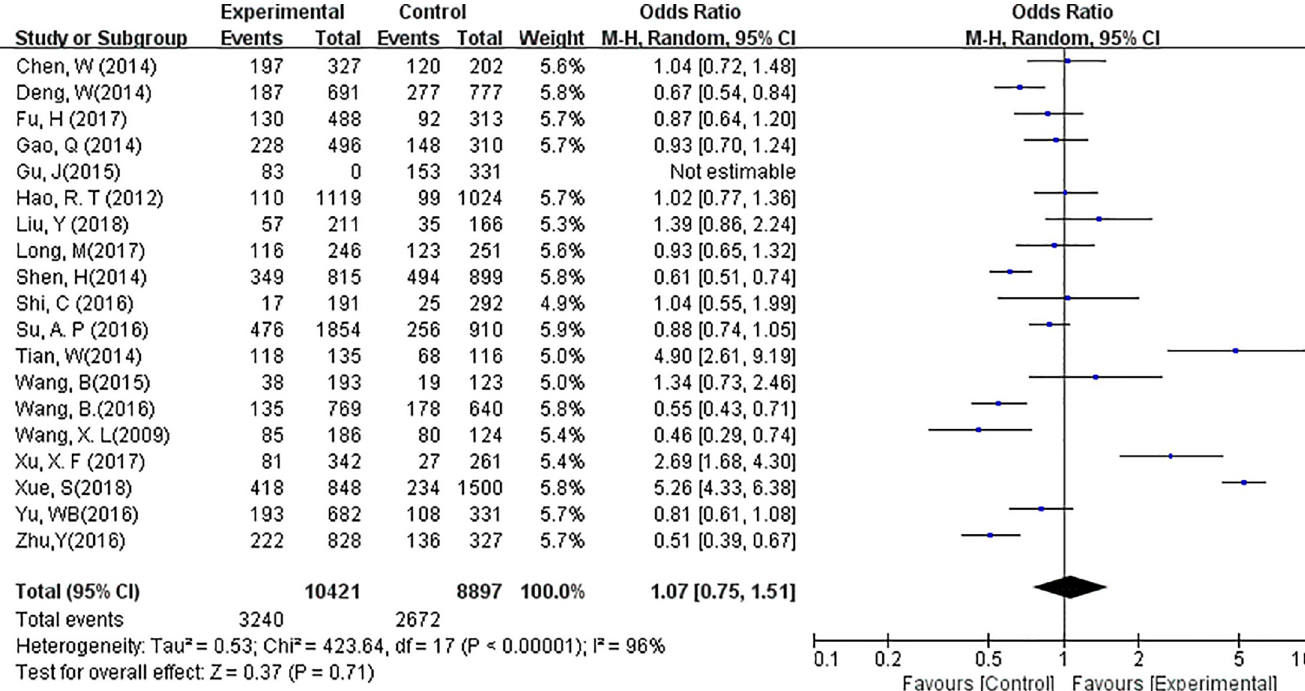
Fig 4. Forest plots of the total metastatic rate of lymph nodes harvested in groups. (Experimental = Carbon nanoparticle group, Control = Blank or methylene blue group, Total = total number of LN, Events = the number of LN with metastasis).